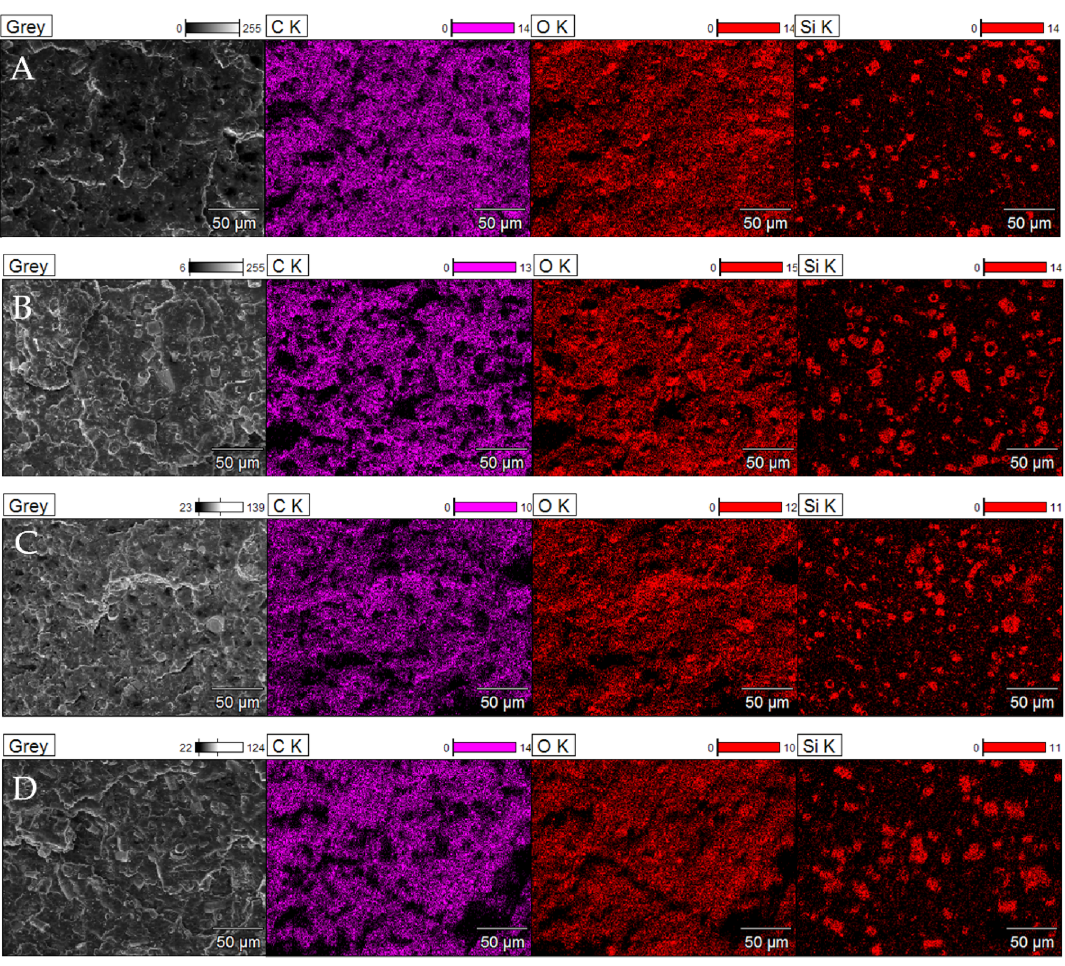
Figure 14. EDS; ( A ) 15B, ( B ) 15B/0.5BW, ( C ) 15B/1BW, ( D ) 15B/0.5SW.